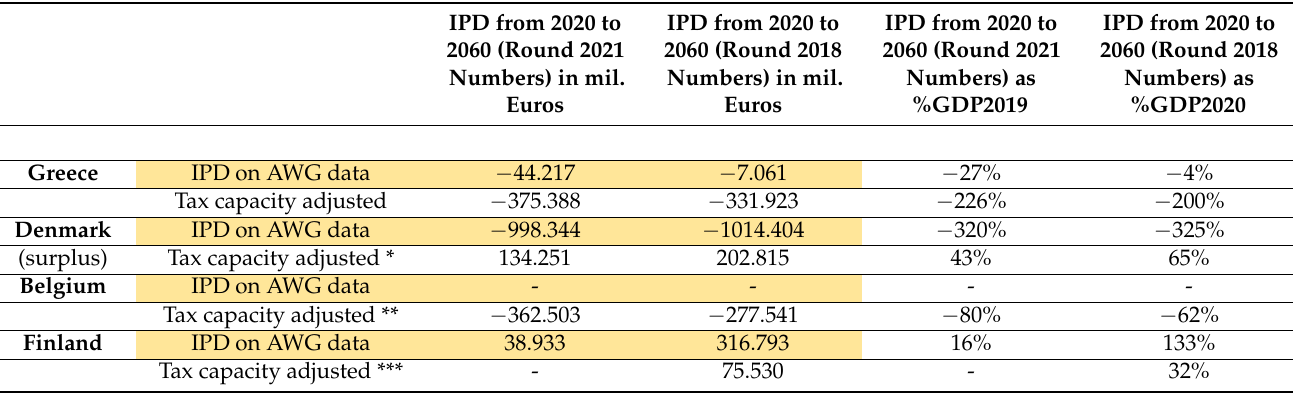
Table 3. Effect of tax capacity corrections for four countries.